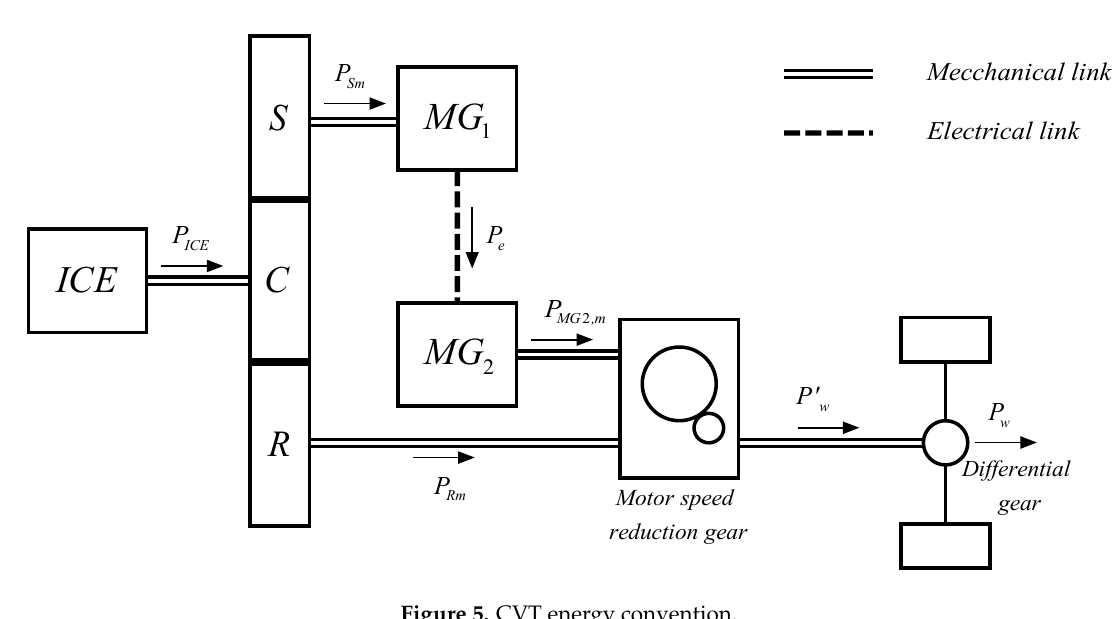
Figure 5. CVT energy convention.